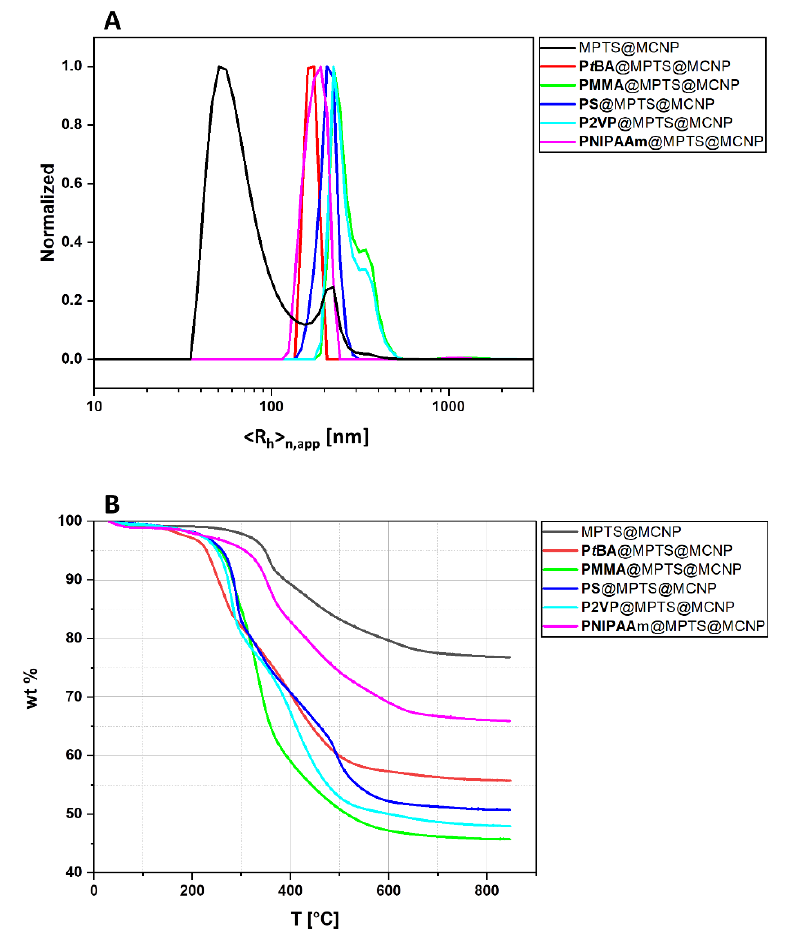
Figure 5. ( A ) Number-weighted DLS CONTIN plots of MPTS@MCNP (black line,